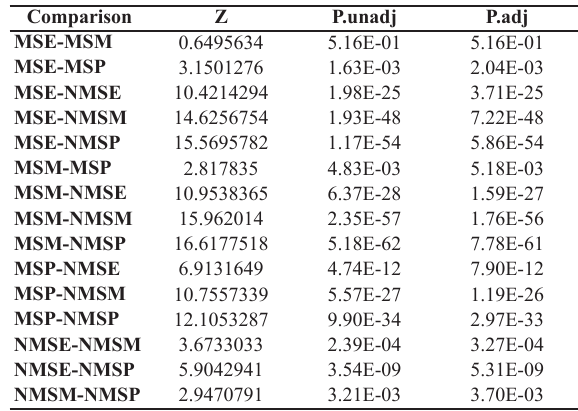
Table 1. Dunn (1964) Kruskal-Wallis multiple comparison. The p-values adjusted with the Benjamini-Hochberg method. MSE (Matching Score Excellent images), MSM (Matching Score Moderate images), MSP (Matching Score Poor images), NMSE (Non-Matching Score Excellent images), NMSM (Non-Match - ing Score Moderate images), and NMSP (Non-Matching Score Poor